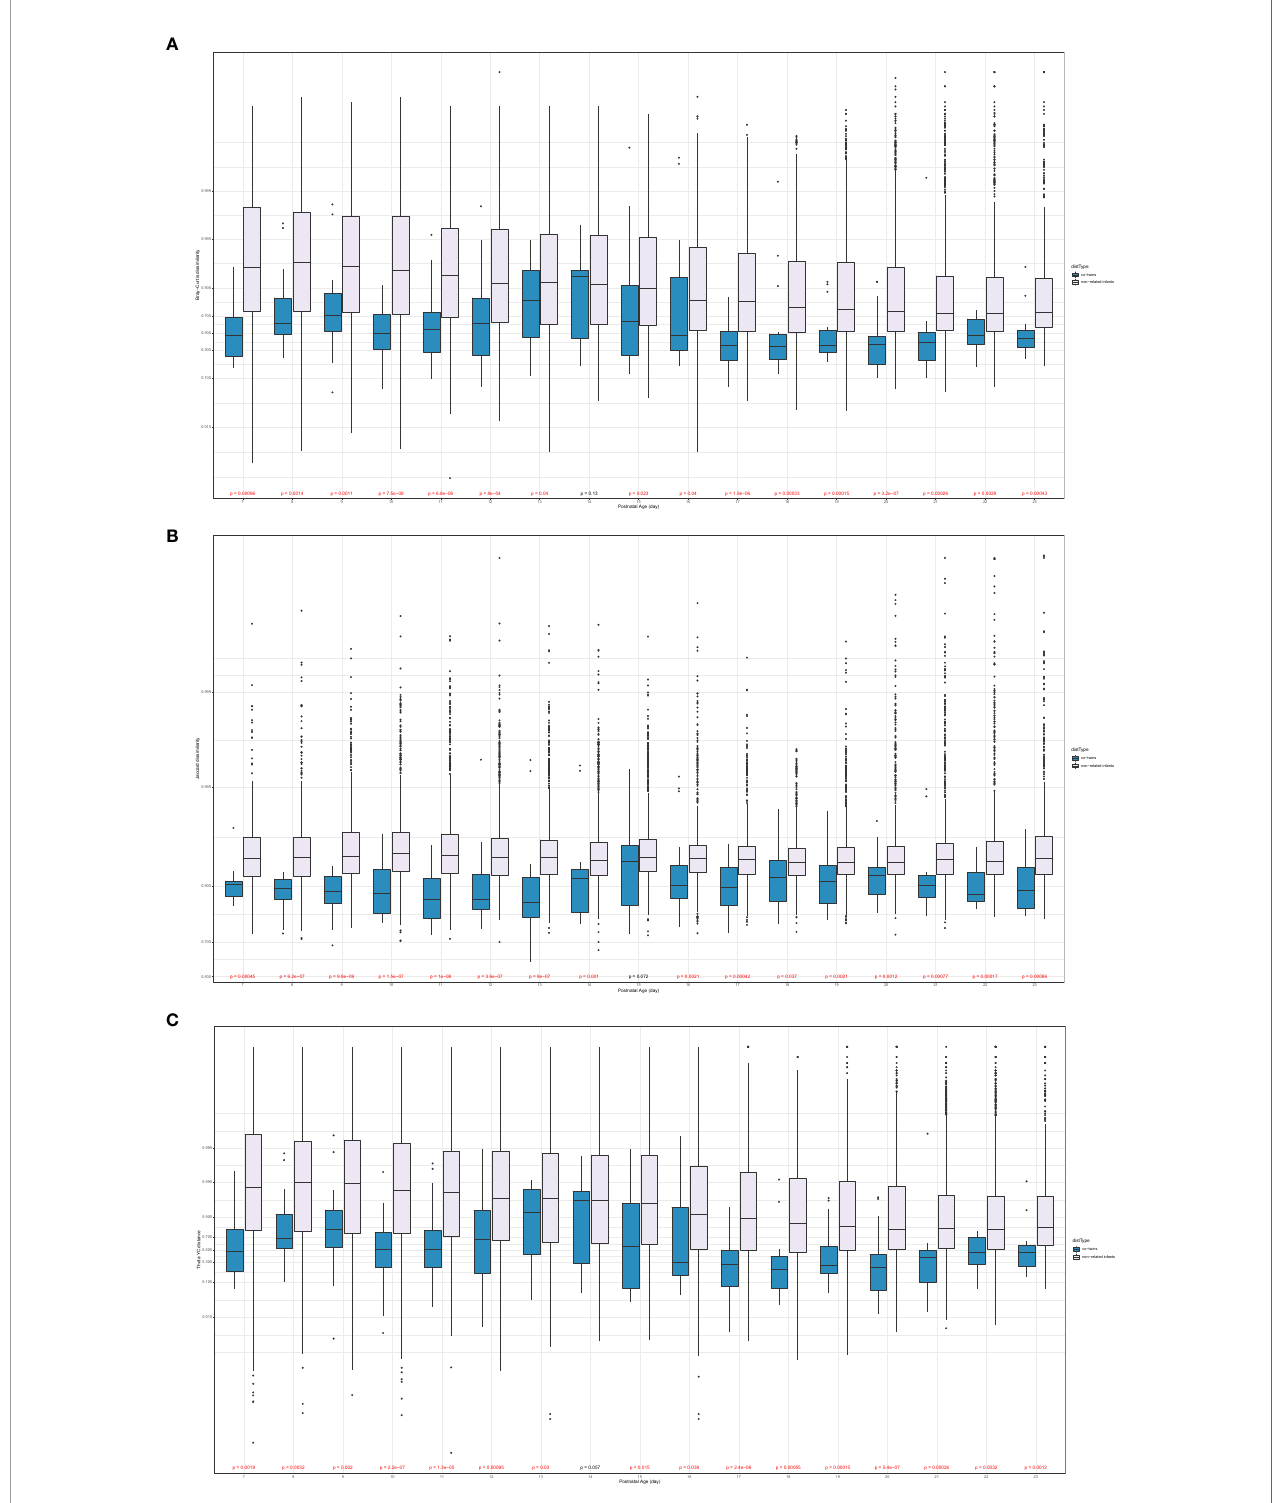
FIGURE 4 | Comparison of the b -diversity of the co-twins/triples with non-related infants from different sex ( A : Bray-Curtis dissimilarity; B : Jaccard dissimilarity; C : Theta YC distance). x-axis: the averaged postnatal age for sample pairs; y-axis: the logit-transformed b -diversity measures between 0 and 1; p values: Mann- Whitney U test, colored in red if it is signi fi